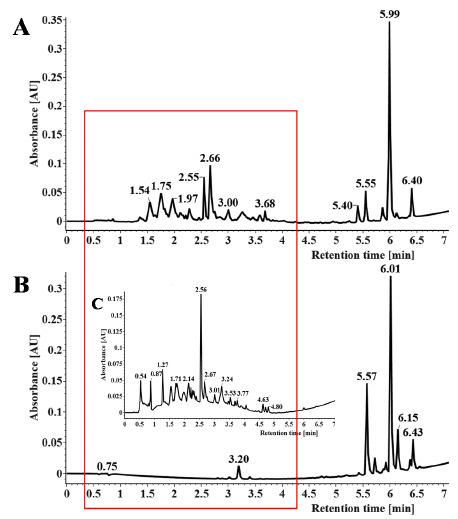
Figure 5. Effects of before- and after-enrichment on the PMF extraction. ( A ) PMF extract solution before and after purification by CNPC1; ( B ) effects of CNPC1 on the ultra-high performance liquid chromatography spectrum of the PMF extract; chromatography spectrum of the PMF